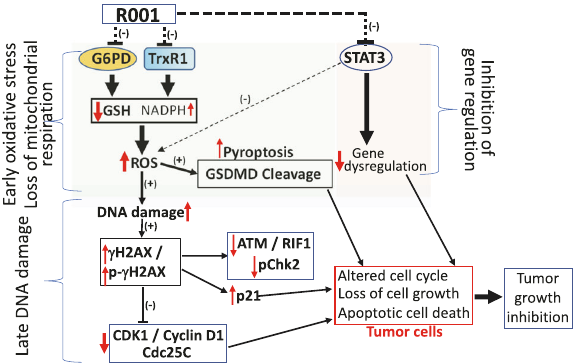
Fig. 7 Model of the underlying molecular mechanisms for the antitumor effects of R001 against human TNBC. R001 inhibits the functions of STAT3, G6PD, and TrxR1 early. The inhibition of constitutively active STAT3 leads to the attenuation of the dysregulation of gene expression caused by aberrant STAT3 activity. The modulation of G6PD and TrxR1 collectively alters both GSH levels, which decrease, and NADPH levels, which increase, and these changes are re fl ective of loss of mitochondrial respiration. These molecular changes contribute to increased ROS production, indicative of oxidative stress, which promotes early pyroptosis (GSDMD cleavage) and a late DNA damage. The consequences of the DNA damage are the induction of the DNA damage response regulators, including p- γ H2AX and γ H2AX, and altered cell cycle pro fi le, with p21 induction and Cdc25C and Cyclin D1 suppression. These alterations together lead to tumor cell growth inhibition and tumor cell death in the R001-treated TNBC cells, and the inhibition TNBC growth in vivo. ( + ), induction, ( − ), inhibition, red up arrow, elevated, red down arrow,